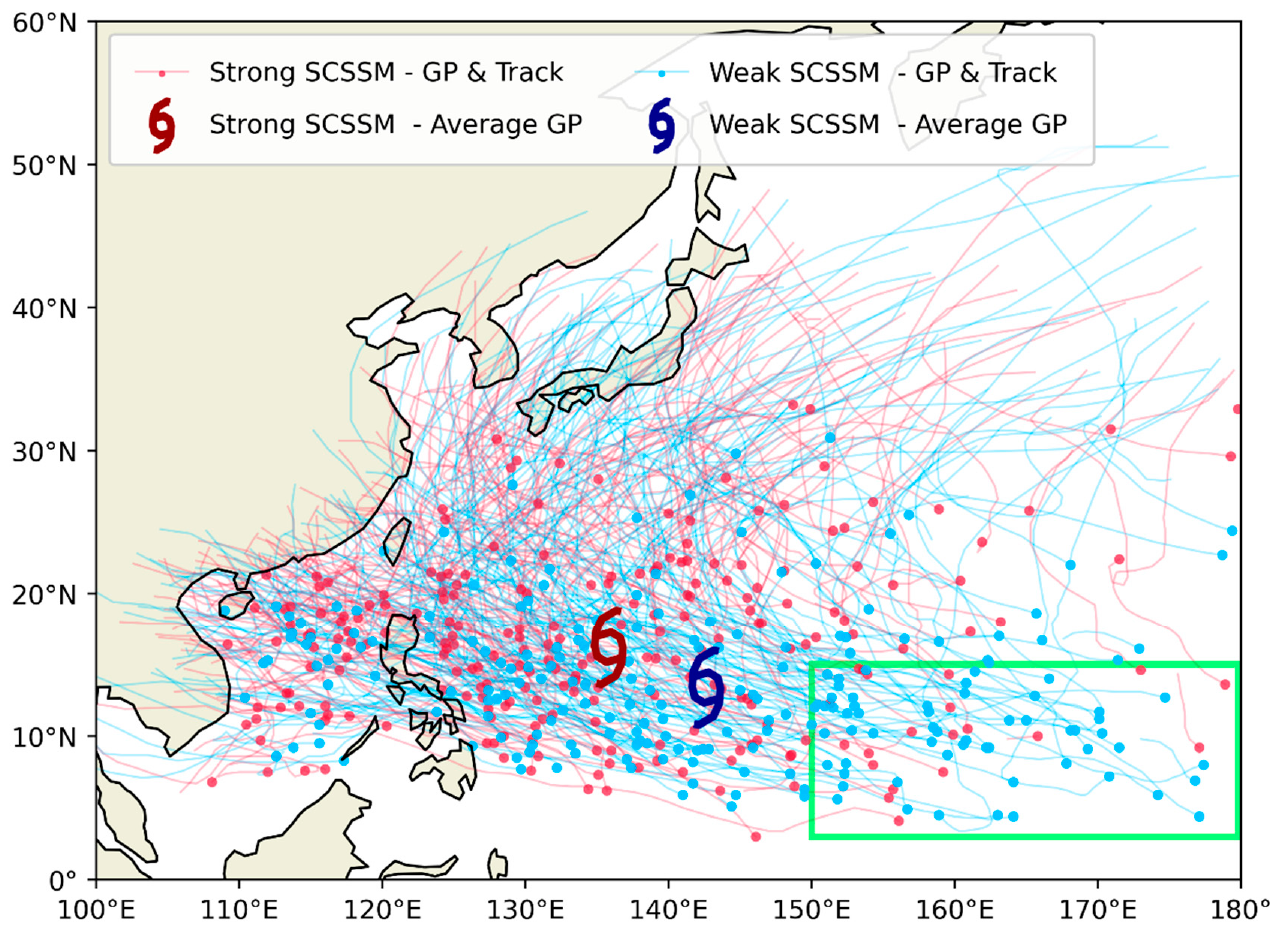
Figure 4. Genesis locations and activity ranges of TCs. Curves represent the TCs tracks, dots the TCs genesis locations, and cyclone symbols the TCs average genesis positions over WNP during TC season. The colors red and blue are used to distinguish between strong and weak SCSSM years, respectively. Within the green box, the number of TCs genesis per year in strong and weak SCSSM years differs by nearly three times.